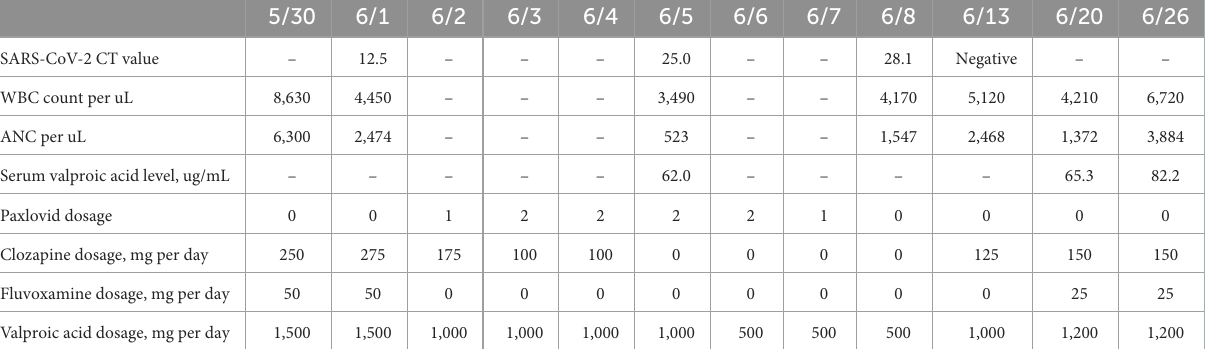
TABLE 1 Summary of medications and laboratory data before and after SARS-CoV-2